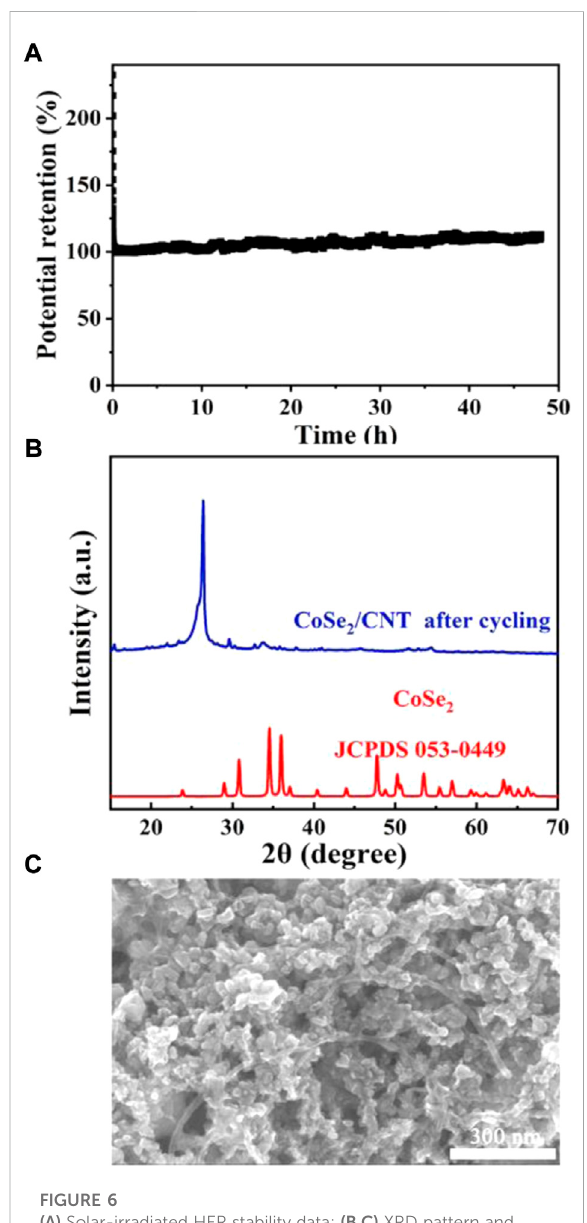
FIGURE 6 (A) Solar-irradiated HER stability data; (B,C) XRD pattern and SEM image of CoSe 2 /CNTs after